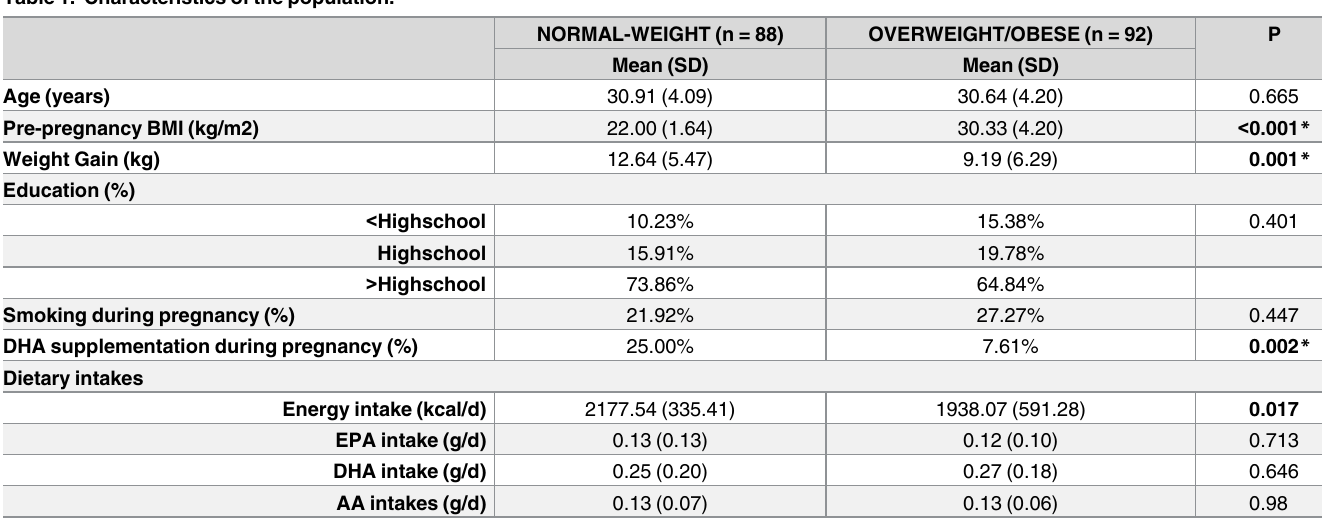
Table 1. Characteristics of the